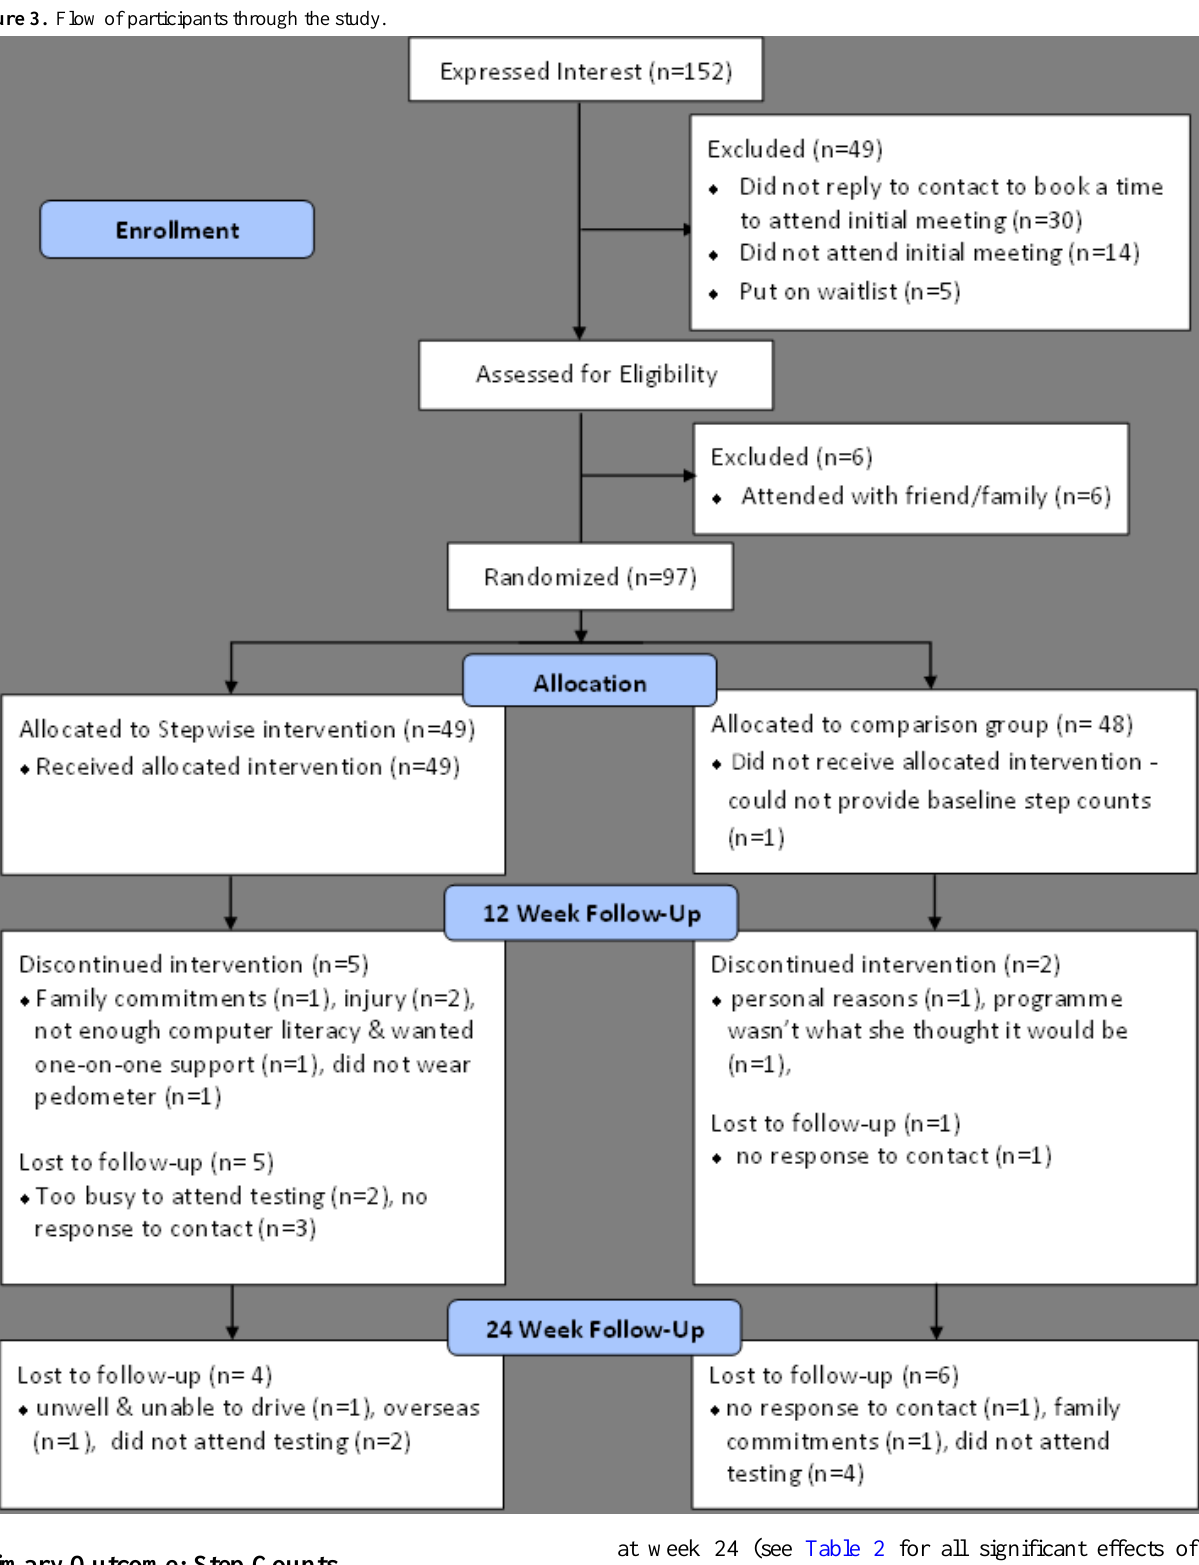
Figure 3. Flow of participants through the